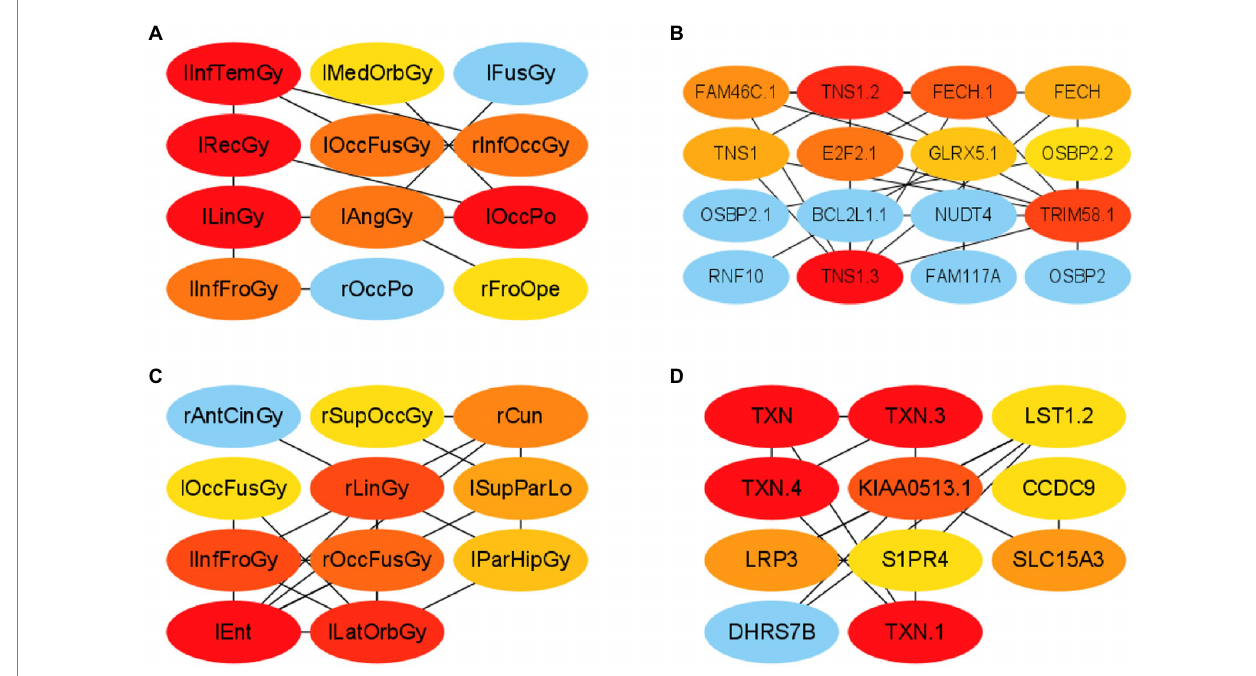
FIGURE 5 Visualization of ROI-ROI and gene–gene interaction networks in the AD and MCI groups. (A,B) are the network diagrams of the ROIs and genes of the AD group, respectively. (C , D) Are the network maps of the ROIs and genes of the MCI group, respectively.